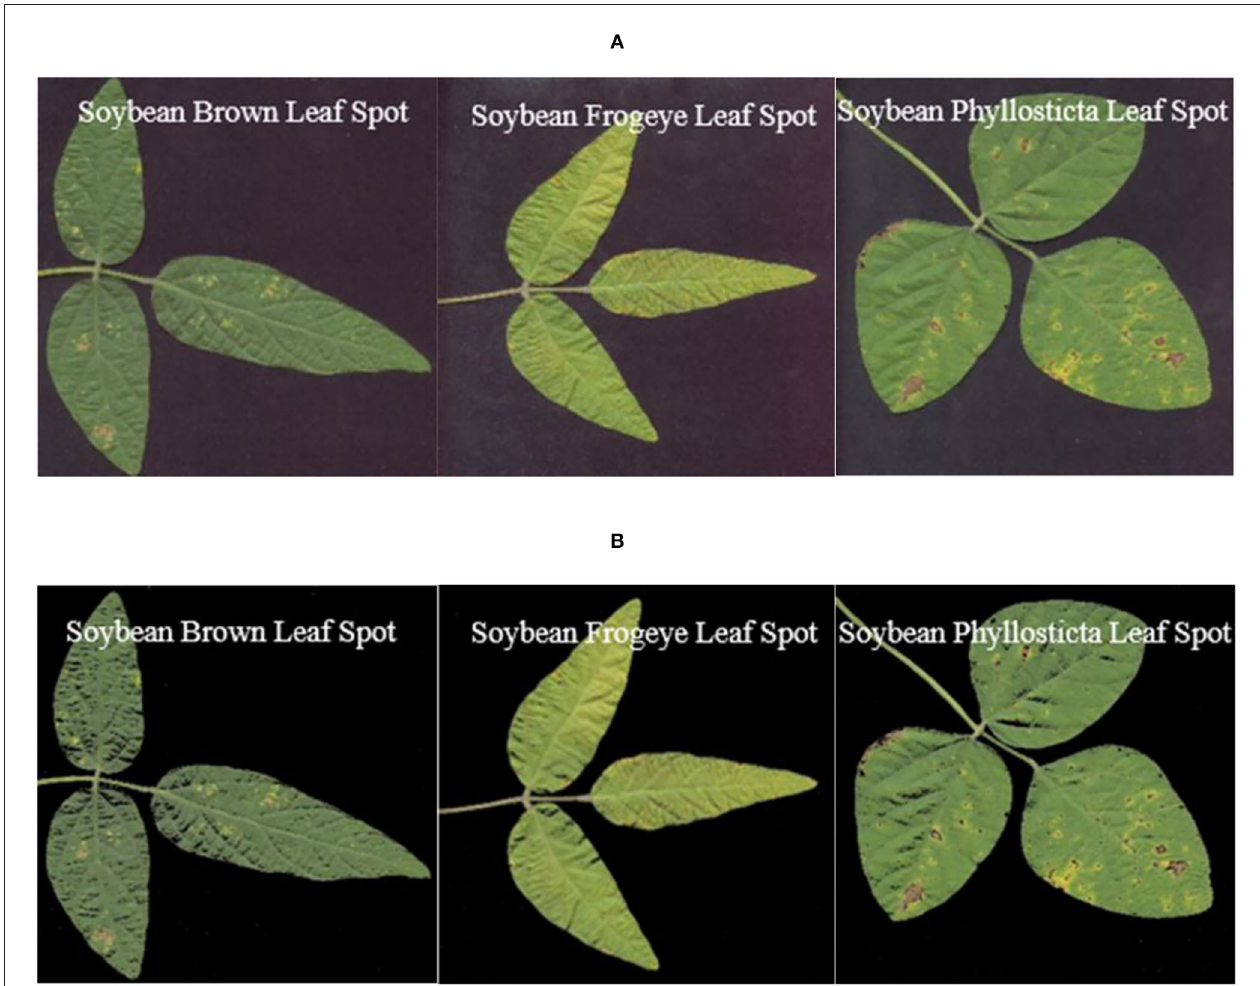
FIGURE 3 | Segmented images of soybean diseased leaves with the iterative method. (A) Original images. (B) Segmented